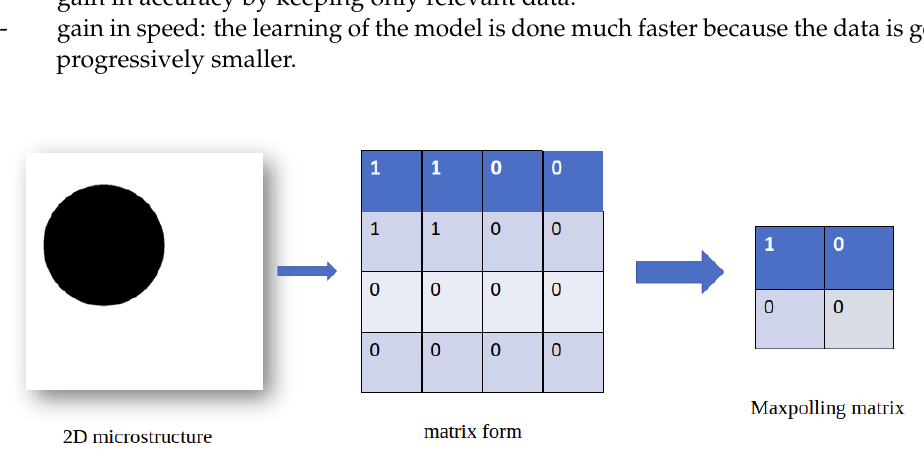
Figure 7. Reduction of the image shape using polling operation consists at extracting the maximum value from each sub-matrix.